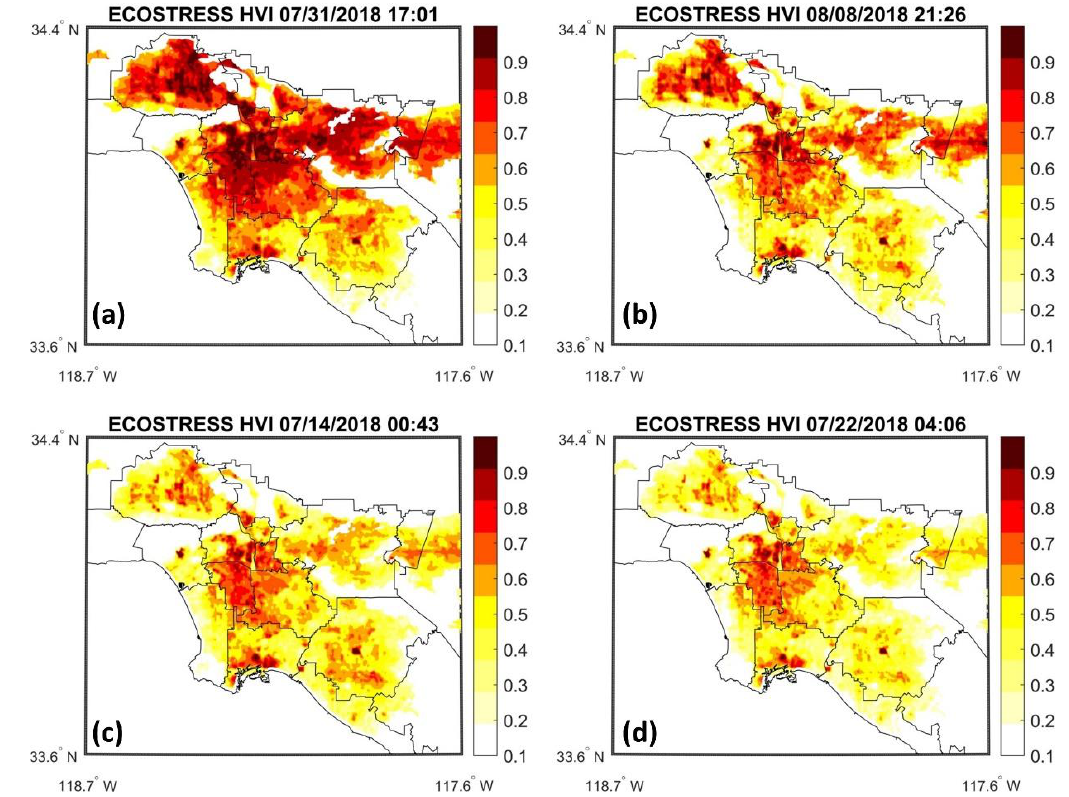
Figure 4. Heat vulnerability index (HVI) maps derived from ECOSTRESS acquisitions for: ( a ) 31 July 2018 at 17:01, ( b ) 8 August 2018 at 21:26, ( c ) 14 July 2018 at 00:43, and ( d ) 22 July 2018 at 04:06. All times are in Pacific Standard Time (PST).